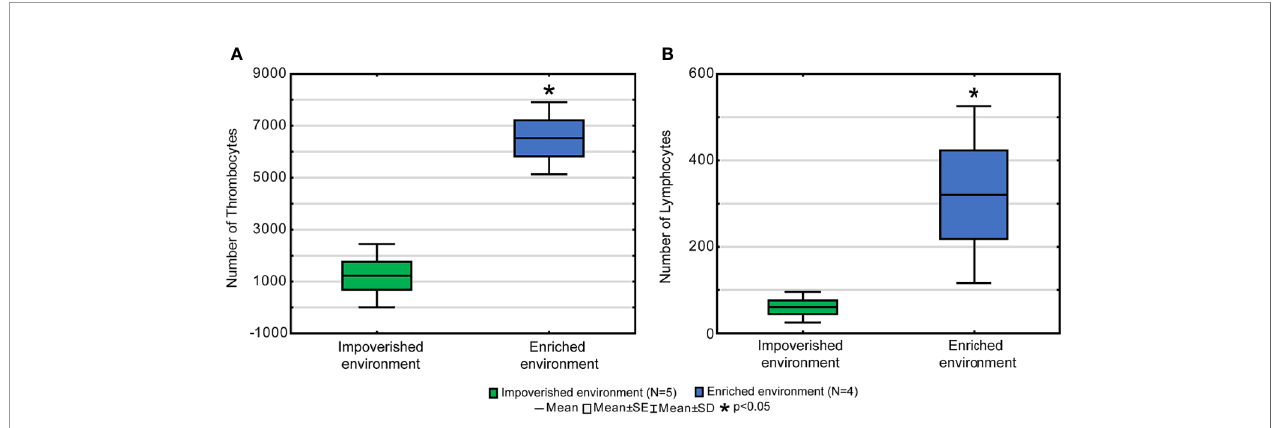
FIGURE 7 | Flow cytometry analysis results of peripheral blood samples of EE and IE fi shes. Note that as compared with IE, a signi fi cant greater number of thrombocytes (A) and lymphocytes (B) are observed in EE fi sh. *p < 0.05.